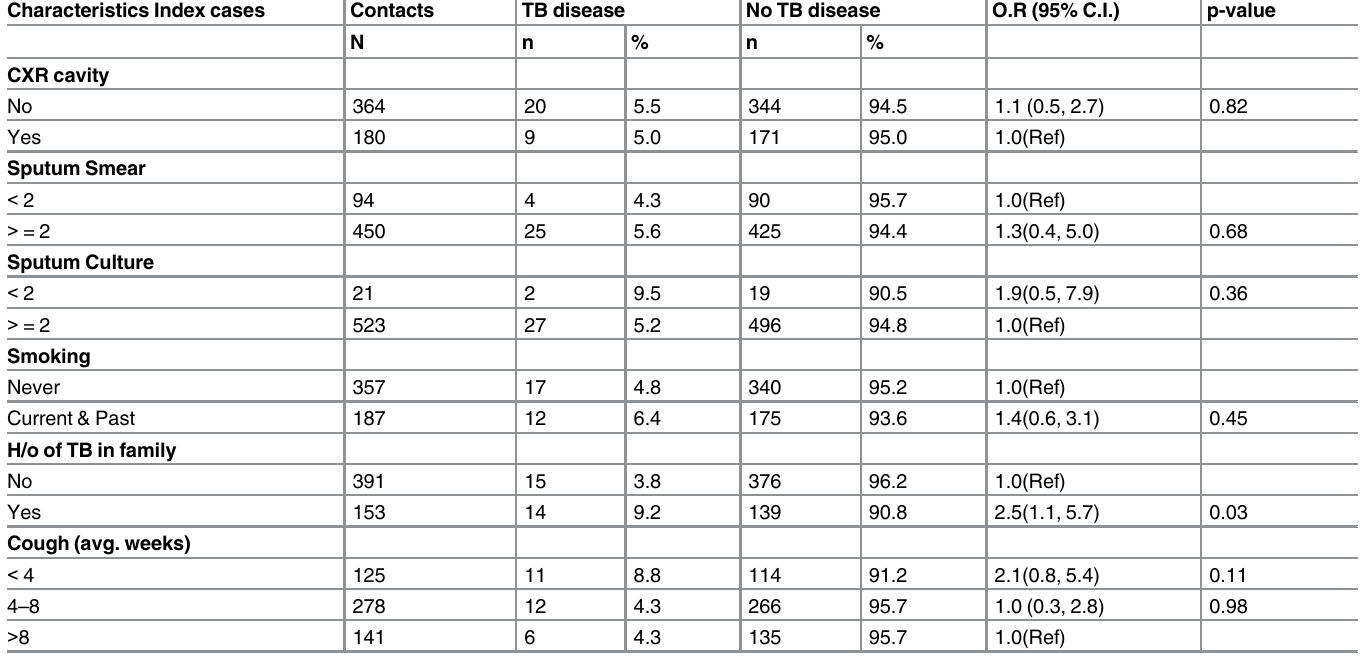
Table 4. Index case factors associated with TB disease among their house hold contacts (N = 544) in Chennai,